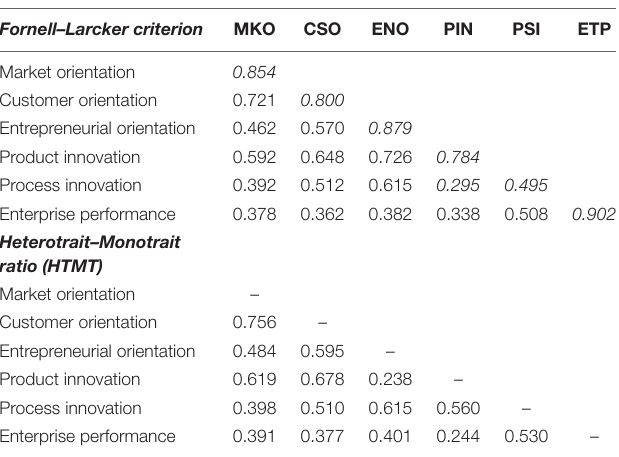
TABLE 2 | Discriminant